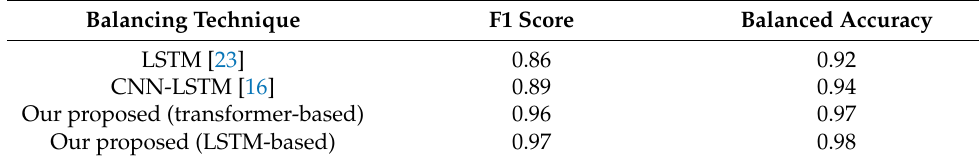
Table 5. Comparison of our proposed methods against existing methods.